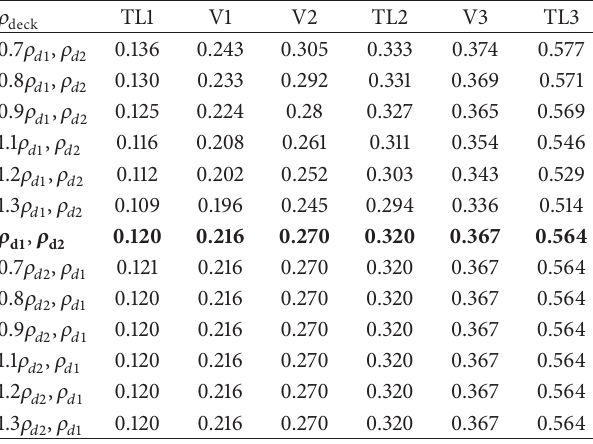
Table 4: Comparison of natural frequencies (Hz) with changes in mass density of steel girders ( 𝜌 𝑑1 ) and PC girders ( 𝜌 𝑑2 ).